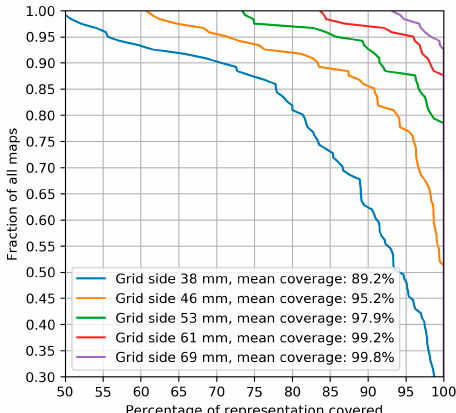
Figure 1. The e ff ect of the grid size on the completeness of muscle representation coverage. For every percentage value X, the corresponding Y value is the fraction of all the maps in which at least X per cent of the representation is covered by the grid of a given size. The simulated grids were located at the peeling depth of 20 mm, centered at the point with the maximum motor evoked potential (MEP) amplitude, had a square shape, and their side lengths were chosen as even integer multiples of a cell in the Nexstim grid tool (10 to 18 cells). The transcranial magnetic stimulation (TMS) maps used in this calculation were obtained without a grid in healthy subjects (13 maps for abductor pollicis brevis (APB), 54 for extensor digitorum communis (EDC), and 54 for flexor digitorum superficialis (FDS)). There was no significant di ff erence in the representation coverage between the muscles for every grid size ( p > 0.05, Kruskal-Wallis test). Note: The estimates of the coverage are conservative in that stimulation points were counted as covered by the grid only if their distance from the hotspot was smaller than one-half of the side of the grid (i.e., excluding the coverage by the corners of the square, which is possible, but not guaranteed under varying grid orientations). The green line corresponds to the grid size used in the present study.